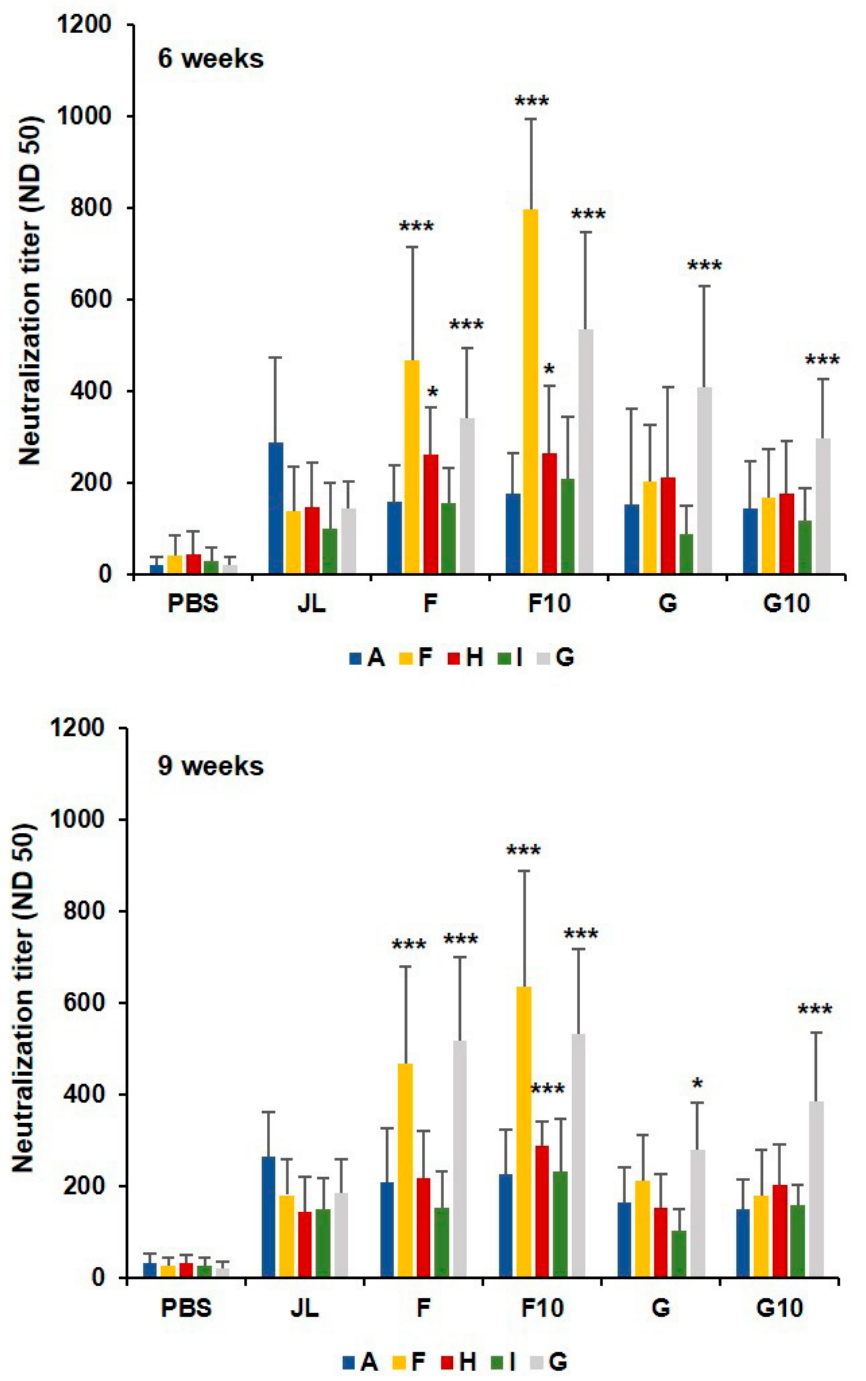
Figure 3. Longevity of humoral immunity of inactivated mumps vaccine candidates. ( A ) Serum- neutralizing antibody responses against diverse genotypes of MuV at 6 and 9 weeks. The average number of spots was calculated in triplicate. The results of 50% neutralizing antibody titers are presented as the mean values from individual mice (N = 10). Neutralizing antibodies against the F, H, and G MuV genotypes were significantly higher in the F10 immunized group (n = 5) compared to the JL immunized group. * p < 0.05, *** p < 0.005 analyzed by unpaired t -test.